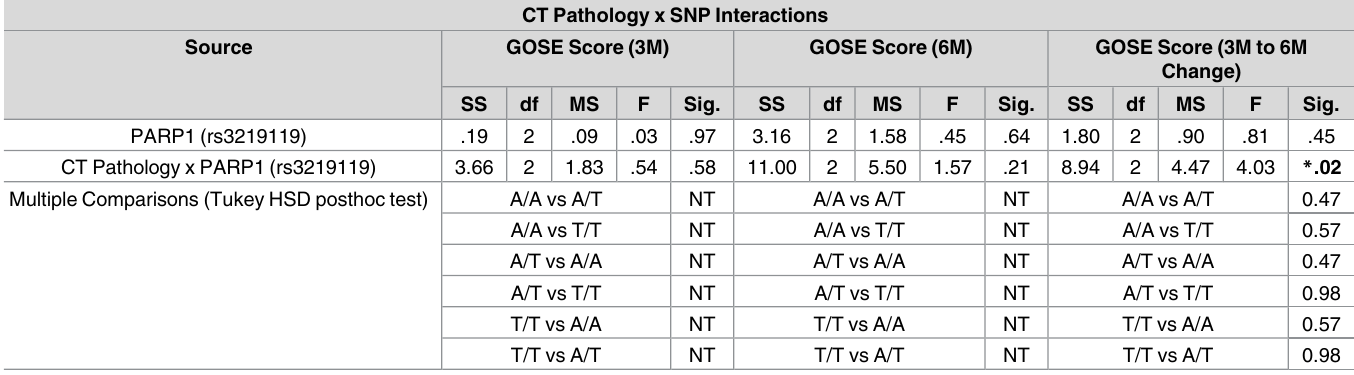
Table 3. General linear model statistics for PARP1 SNP interaction with CT pathology on GOS-E